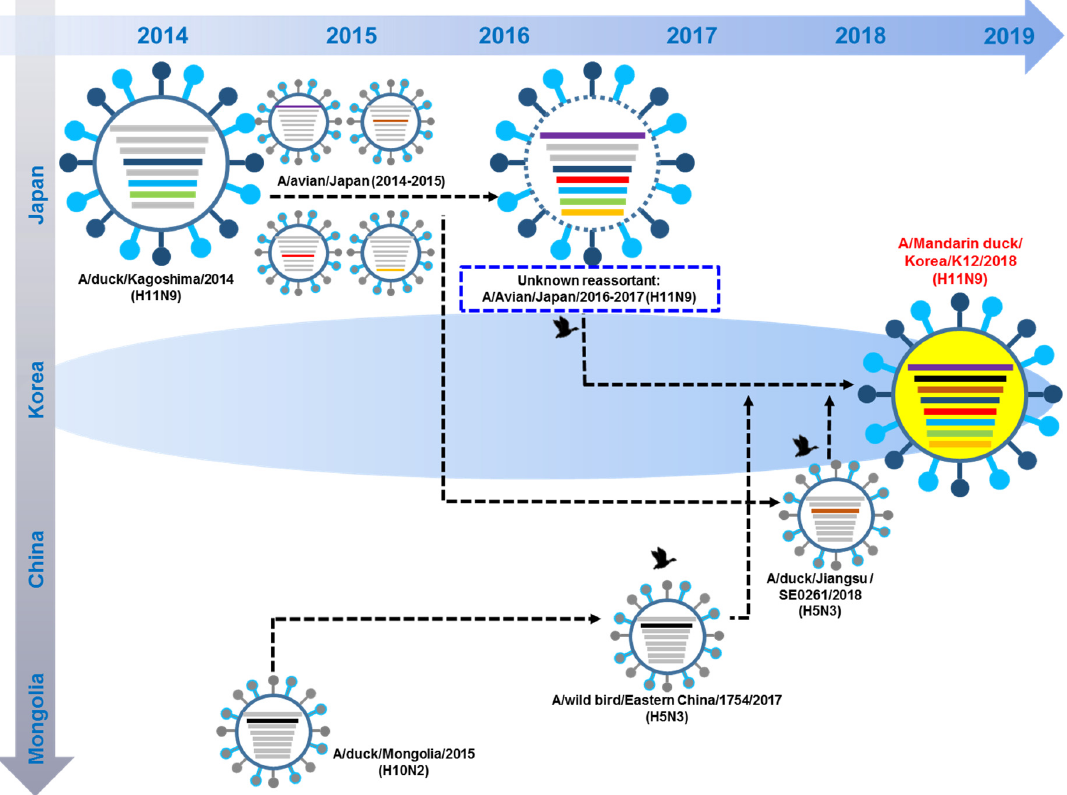
Figure 5. Original reassortment events of novel avian influenza A/Mandarin duck/South Korea/KNU18-12/2018(H11N9). The 8 gene segments (from top to bottom) in each virus are polymerase basic 2 (-), polymerase basic 1(-), polymerase acidic (-), hemagglutinin (-), nucleoprotein (-), neuraminidase (-), matrix (-), and nonstructural (-). Each virus diagram indicates a separate virus.